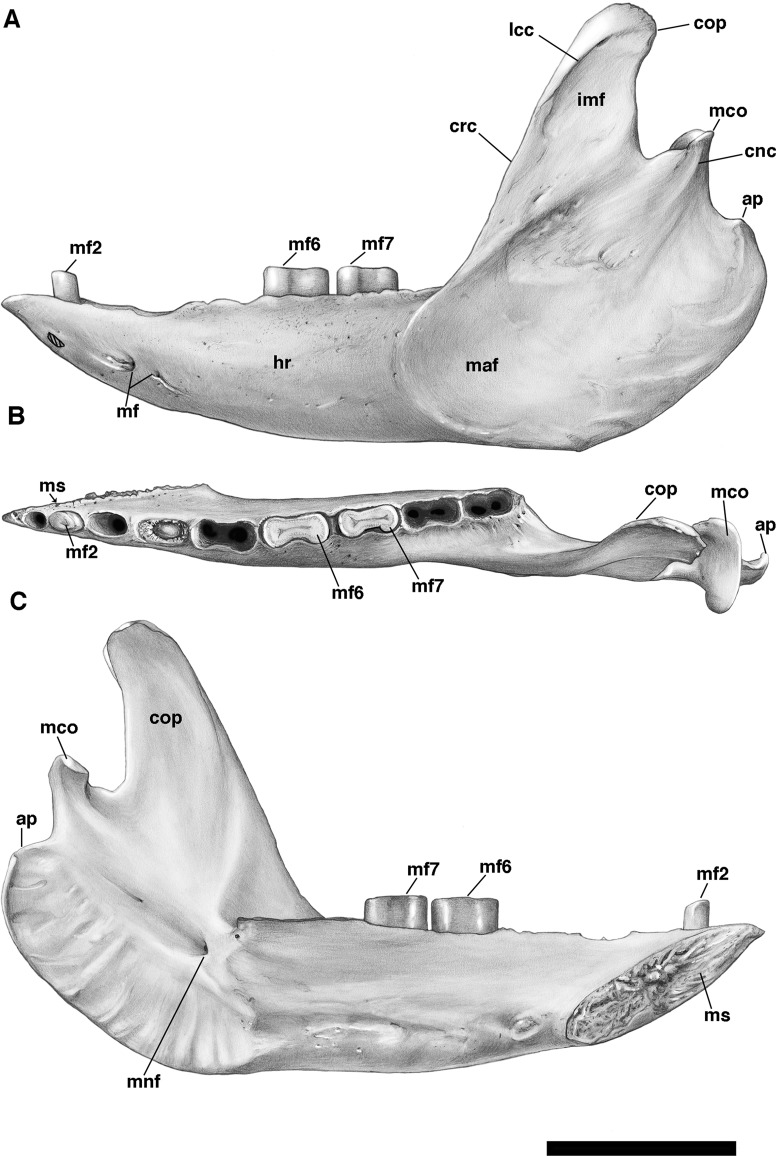
Left mandible of Holmesina floridanus (UF 224450) in (A) lateral; (B) occlusal; and (C) medial views.ap, angular process; cnc, condyloid crest; cop, coronoid process; crc, coronoid crest; hr, horizontal ramus of mandible; imf, intermuscular fossa; lcc, lateral coronoid crest; mf2, second lower molariform tooth; mf6, sixth lower molariform tooth; mf7, seventh lower molariform tooth; maf, masseteric fossa; mco, mandibular condyle; mf, mental foramen; mnf, mandibular foramen; ms, mandibular symphysis. Scale bar = 5 cm.